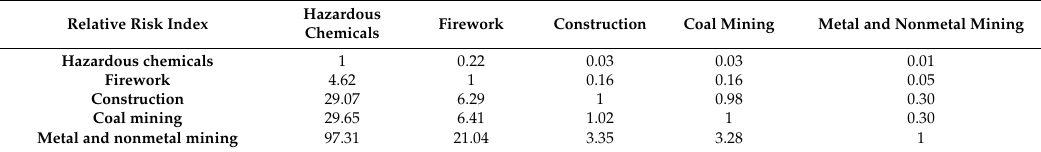
Table 4. Relative risk index between five high-danger industries during the 12 th FYP in